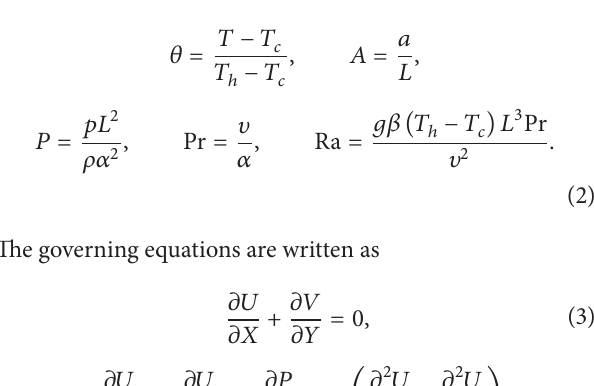
Figure 1: Geometrical model of the